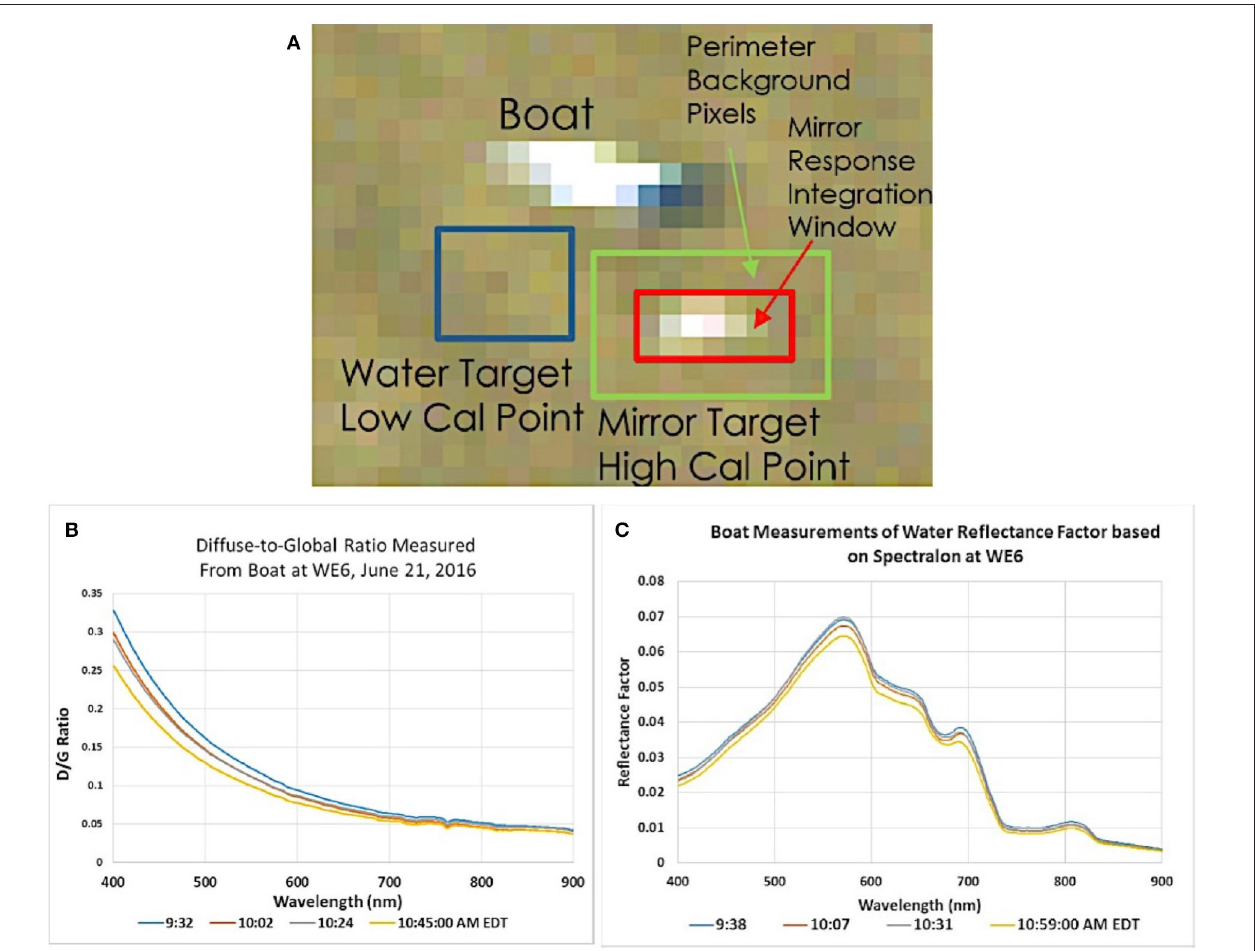
FIGURE 2 | (A) NASA Glenn, second generation Hyperspectral imager (HSI2) image pixels from swath 15_MBSP, acquired on June 21, 2016, of the mirror reflectance target (red box: high calibration point), water (blue box: low calibration point) and boat at station Western Erie 6 WE6. Though the mirror target is smaller than an instantaneous field of view (IFOV) pixel, the energy reflected at the mirror is spread out over multiple pixels due to the aircraft motion, sensor system point spread function and pixel resampling during processing. Pixels included in target integration are indicated by green and red boxes. (B) Example diffuse to global